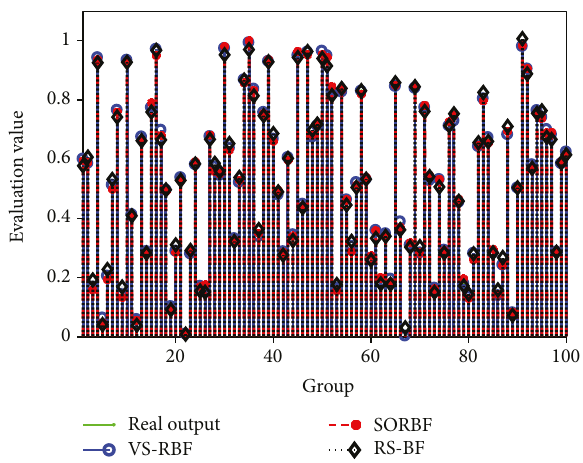
Figure 13: Output value of evaluation of the sortie generation capacity of the carrier aircraft.